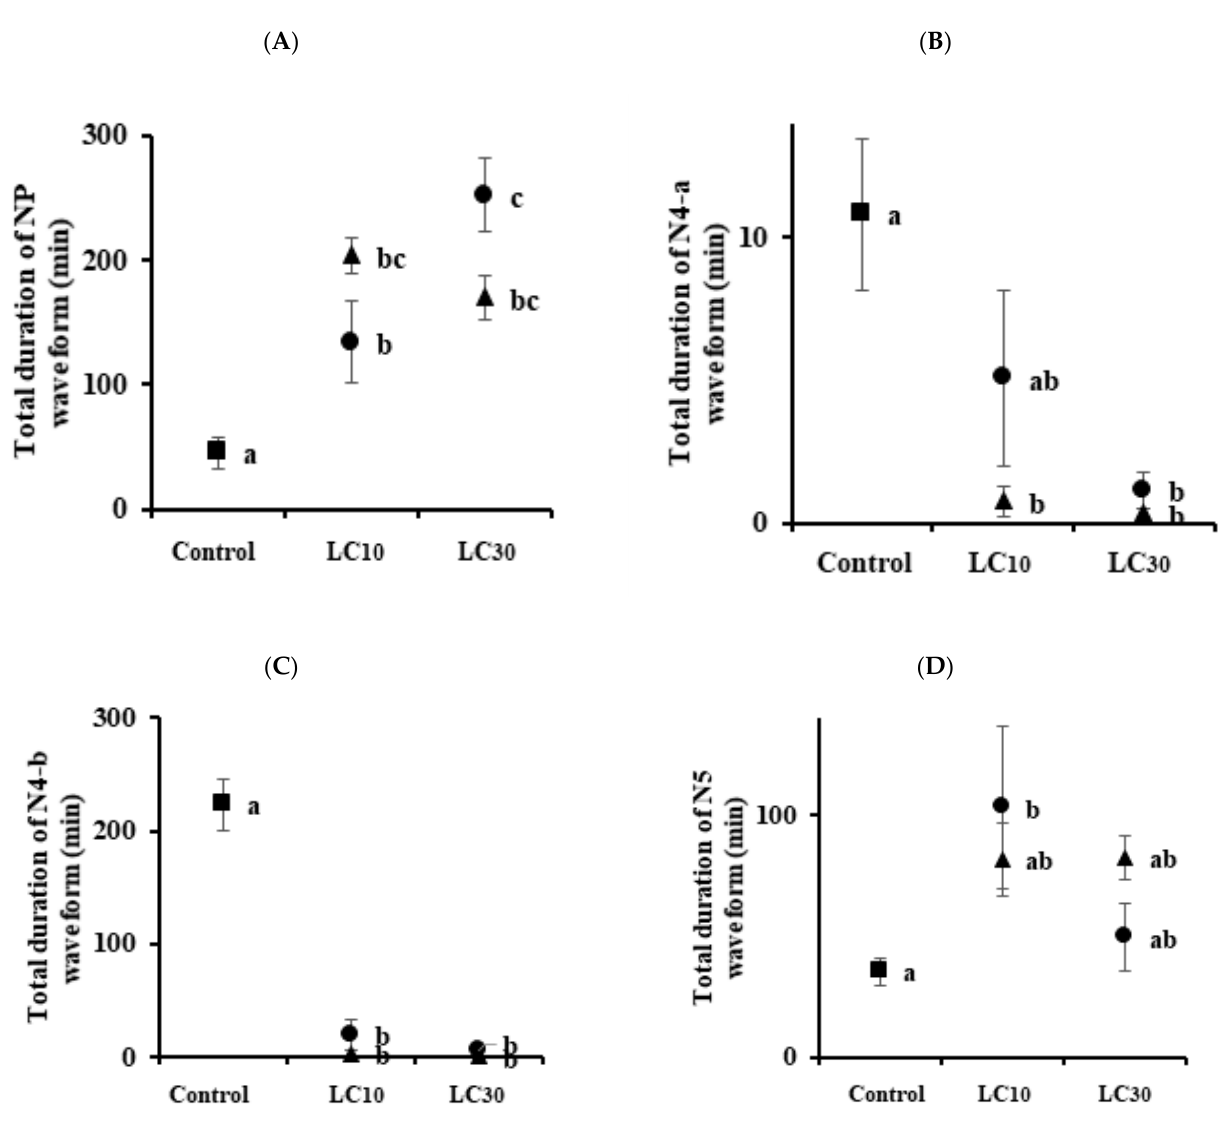
Figure 3. Relationship between two insecticide concentrations and the total duration of each EPG waveform for S. furcifera . Panel ( A ) is the duration of the NP waveform, panel ( B ) is the N4-a waveform, panel ( C ) is the N4-b waveform, and panel ( D ) is the N5 waveform. Triangles are imidacloprid-treated groups and circles are sulfoxaflor-treated groups. Means followed by the same letters are not significantly different ( p = 0.05; Tukey’s studentized range test (SAS Institute 9.0 (SAS, 2009)). Error bars indicate ± SE.